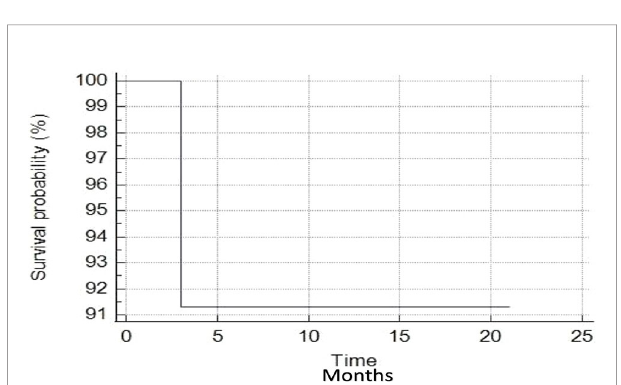
FIGURE 2 | Biochemical relapse-free survival curve.